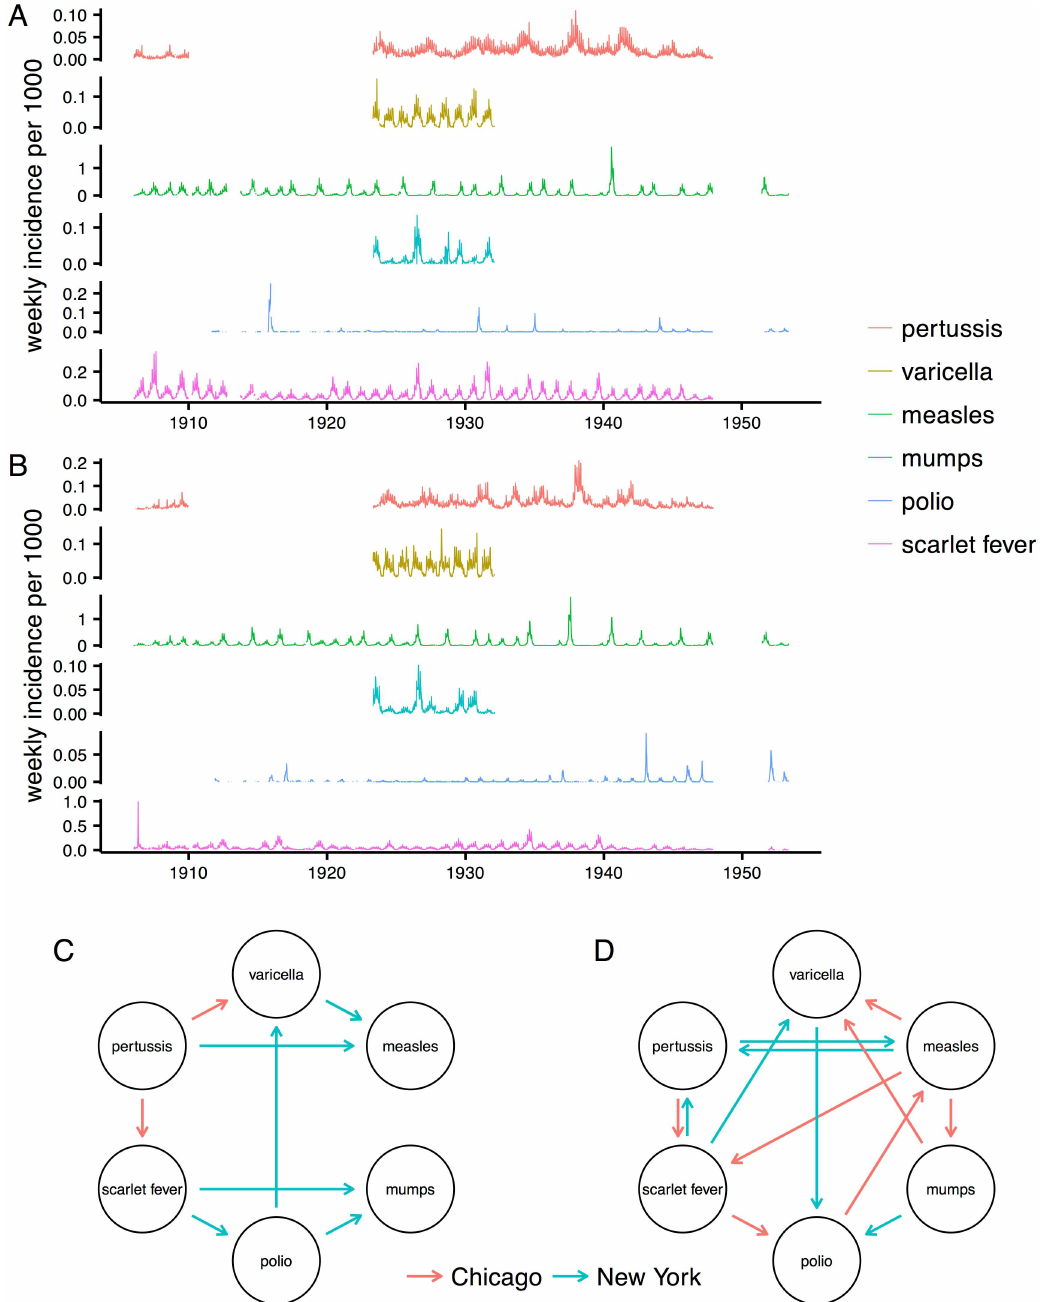
Fig 6. Historical childhood infections in New York City and Chicago and inferred interactions from two reconstruction methods. Time series show weekly incidenceof infectionsper 1000 inhabitants of New York City (A) and Chicago(B). Delay-embeddings were constructed by maximizingthe univariatecorrelation(C) or through a random projectionmethod (D) Arrows indicate the inferred interactions from the New York (blue) and Chicago(red) time series under Criterion 2 (negative cross-map